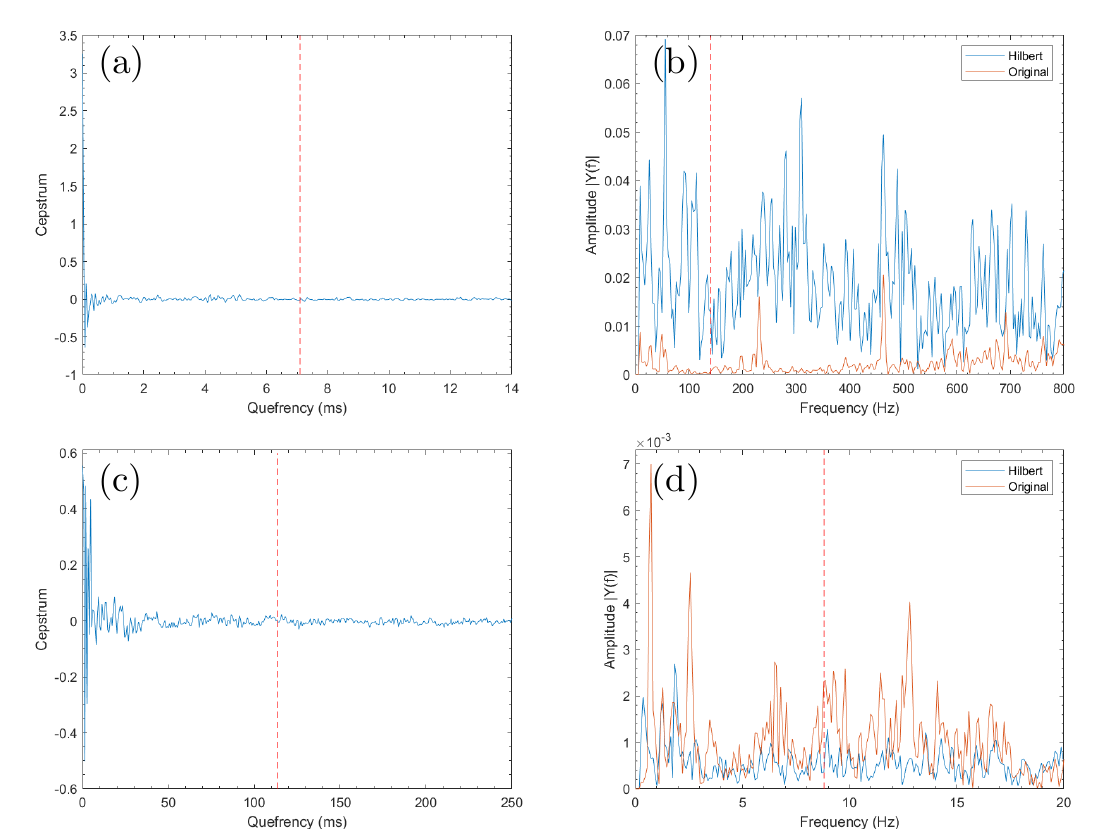
Figure 10. Conventional techniques applied to vibration signal recorded from planetary gearbox of wind turbine with bearing and gear defect. ( a ) The Cepstral analysis on the original signal with red dashed line on 7.1 ms representing the gear-mesh of the planets at 140.8 Hz. ( b ) The Hanning windowed single sided FFT amplitude of both original signal and its Hilbert transform with the red dashed line on 140.8 Hz corresponding to the plants gear-mesh. ( c ) Same as ( a ) with the red dashed line showing BPFI of the bearing of planets at 114 ms or 8.8 Hz. ( d ) Same as ( b ) with the red dashed line showing BPFI of the bearing of planets at 8.8